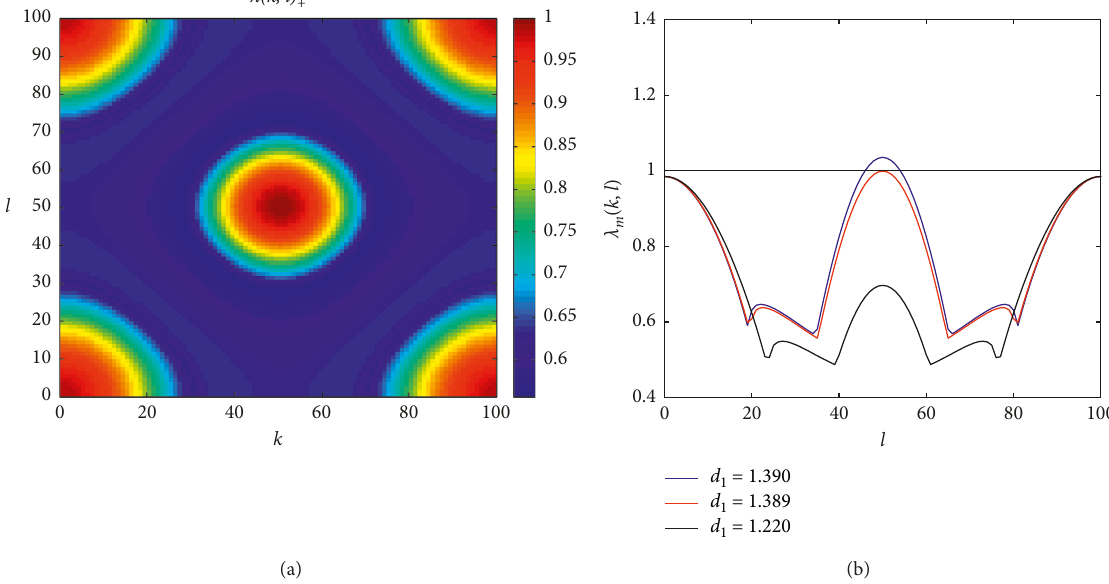
Figure 3: Variation of eigenvalues λ ( k, l ) with perturbation numbers k and l . Parameter values: I � 1 . 6, a � 0 . 5, b � 0 . 8, α � 0 . 7, e � 0 . 2, m � 0 . 45, d � 0 . 20, q � 0 . 01, τ � 0, h � 1, ε � 0 . 001, and n � 100. 2